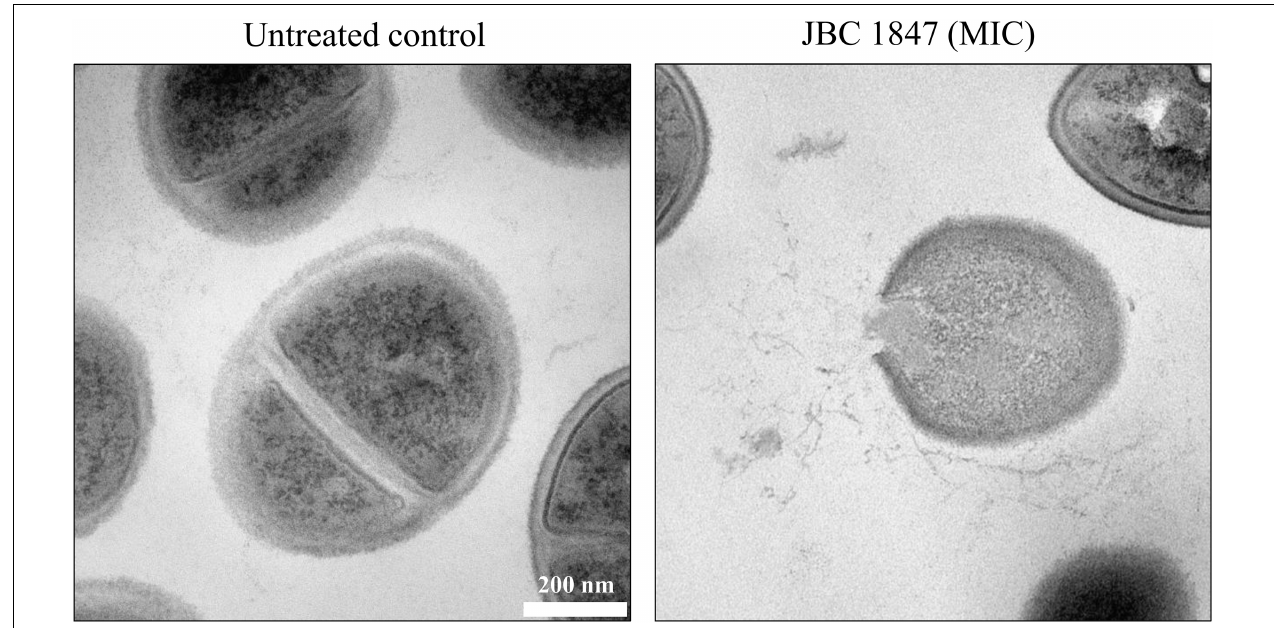
FIGURE 3 | Transmission electron microscopy. The two transmission electron microscopy (TEM) photos show Staphylococcus aureus USA300 JE2 untreated and treated with JBC 1847 in